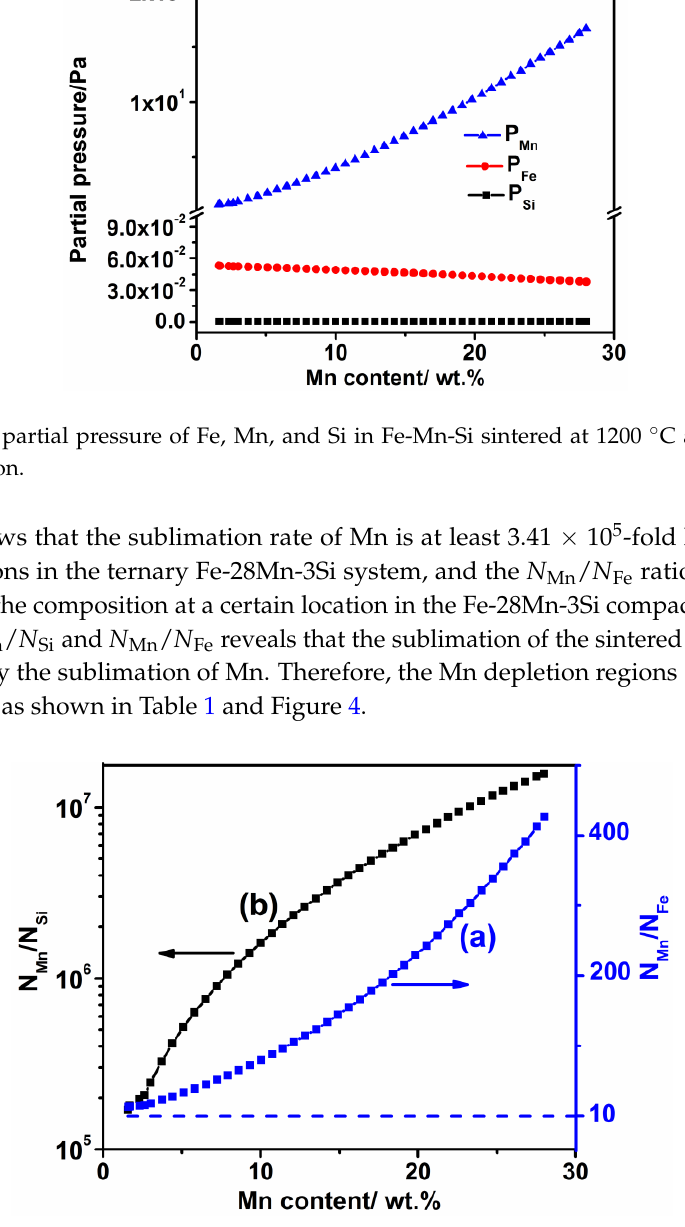
Figure 12. Sublimation rate ratio between the two different components in Fe-Mn-Si alloys at 1200 °C. ( a ) N Mn / N Fe ; ( b ) N Mn / N Si . ( a ) N Mn / N Fe ; ( b ) N Mn / N Si